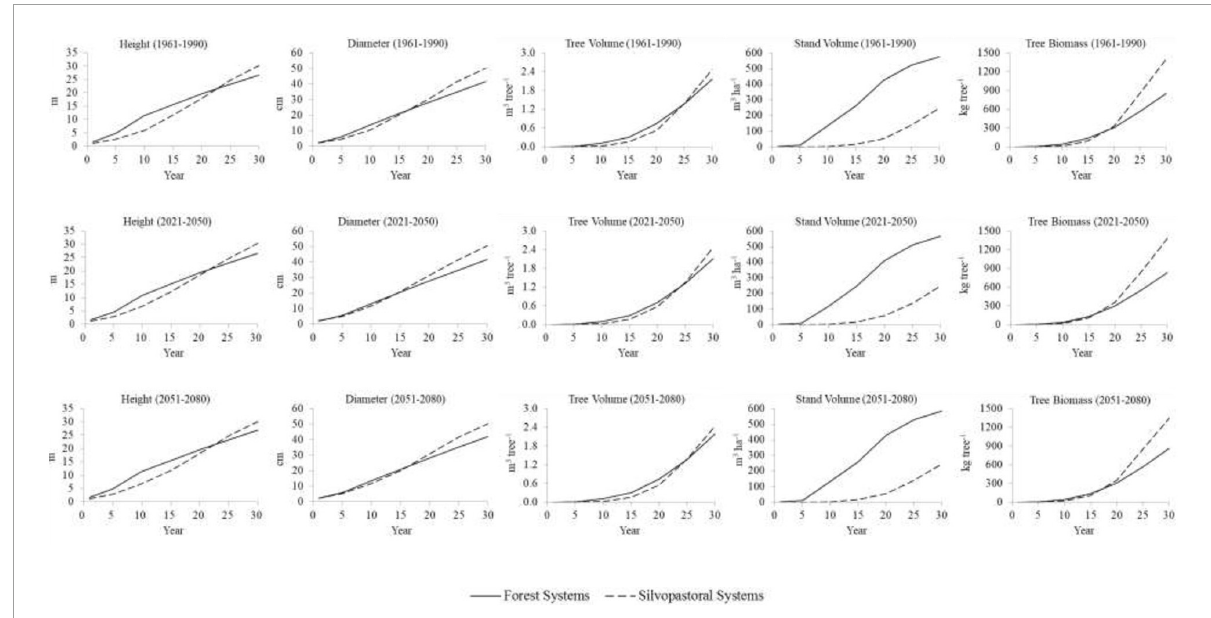
FIGURE4 Growth of Pinus radiata simulated with the Yield-SAFE model in hypothetical forest and silvopastoral systems under different scenarios of climate established through the CliPick tool (Palma, 2017): (i) climate from 1961 to 1990, (ii) climate from 2021 to 2050, and (iii) climate from 2051 to